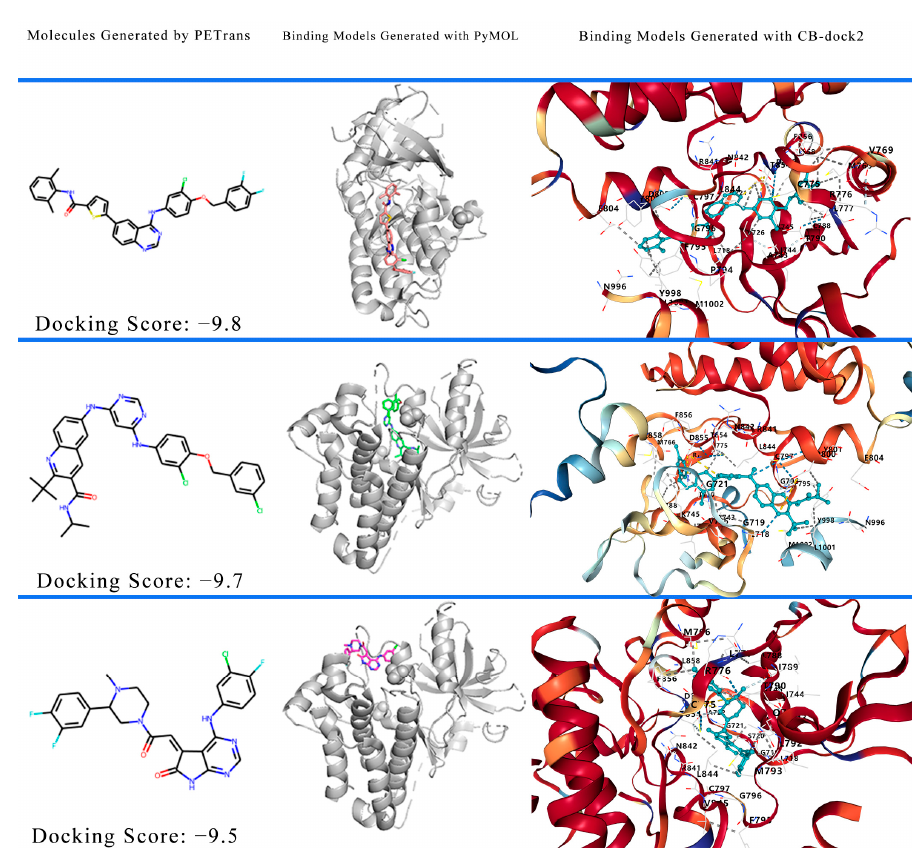
Figure 2. Binding model of the generated molecule. Positions of the generated molecules at the binding sites of the target protein. Each molecule shows the molecular structure (left) and the docked complex structure generated with PyMOL (middle) and CB ‐ dock2 (right), respectively.